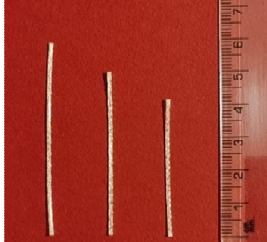
Figure 2. Polypropylene fibers used in the mixture (in centimeters). Table 1. Mixture design for a cubic meter of concrete f c = 40 MPa.